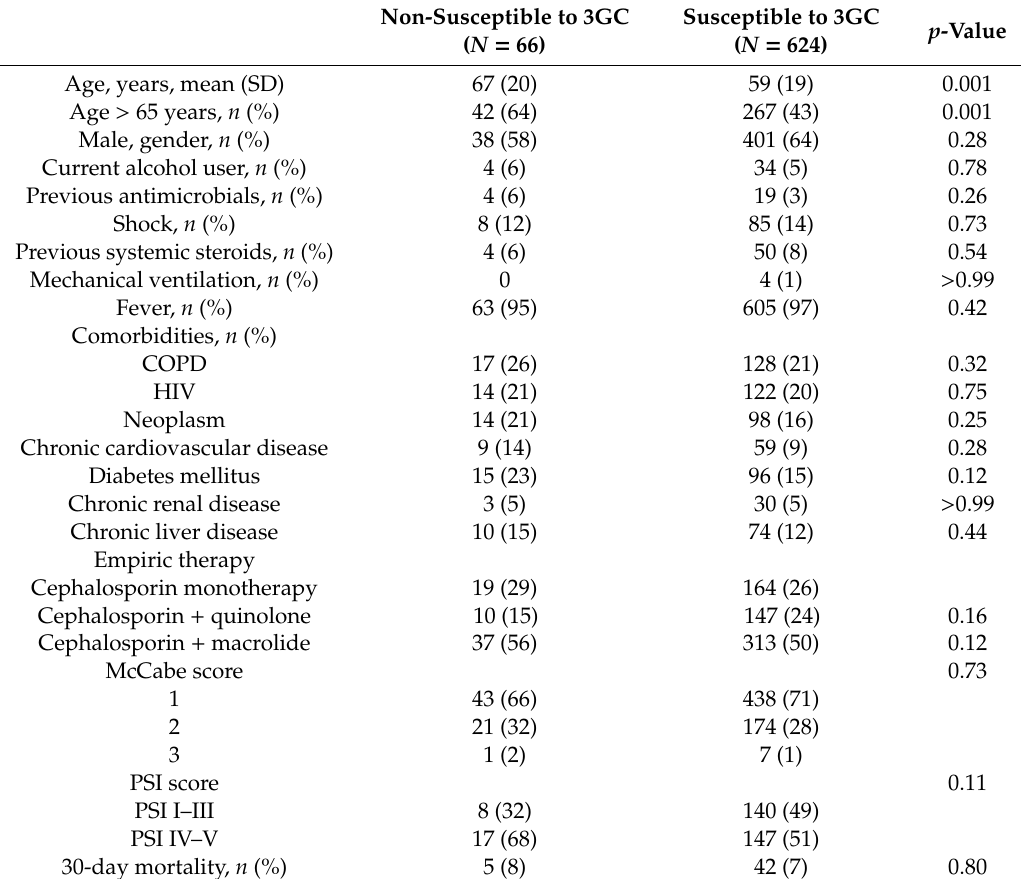
Table 1. Patient demographics and clinical characteristics at